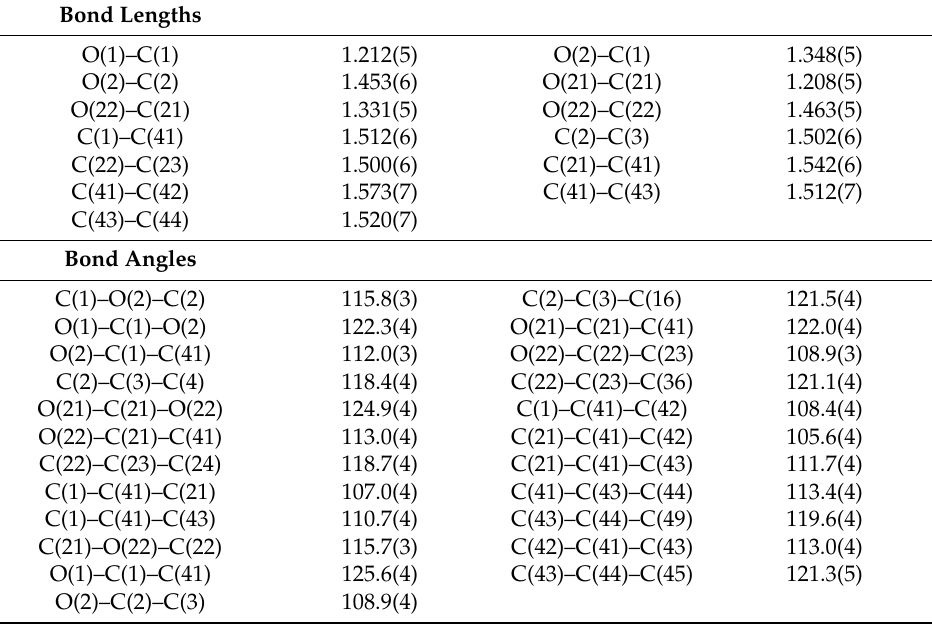
Table 2. Selected bond lengths (Å) and angles (deg) for bispyrenyl malonate 1